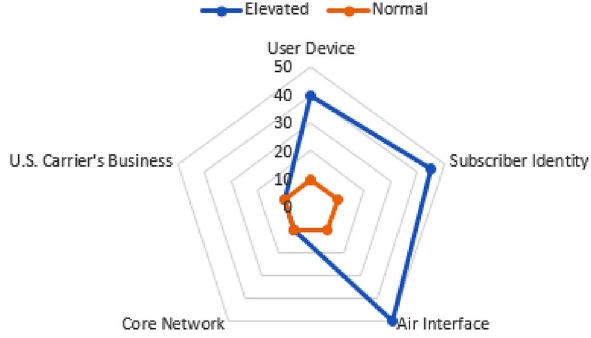
Fig. 4 Signal jamming downgrade risk